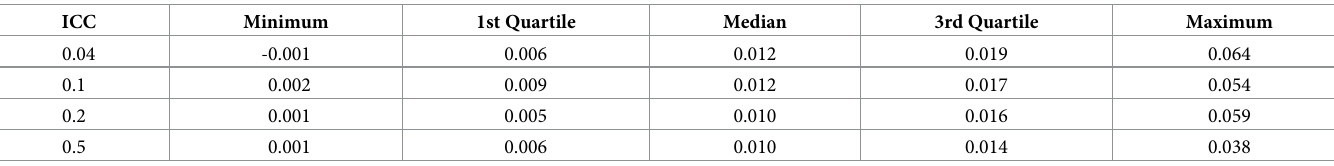
Table 1. Deviations between approximate and empirical power in cluster randomized designs by